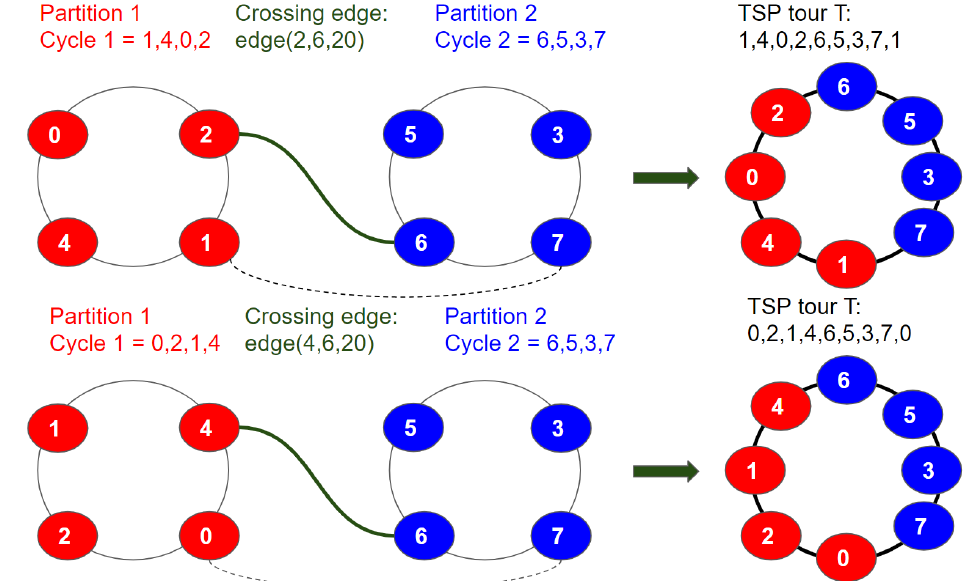
Figure 4. The process of combining TSP tours of different partitions. The red color is partition 1 and the blue color is partition 2. The solid line is used to connect intermediate vertices, and the dotted line is used to connect the head vertex of the TSP tour of the red partition to the tail vertex of the tour of the blue